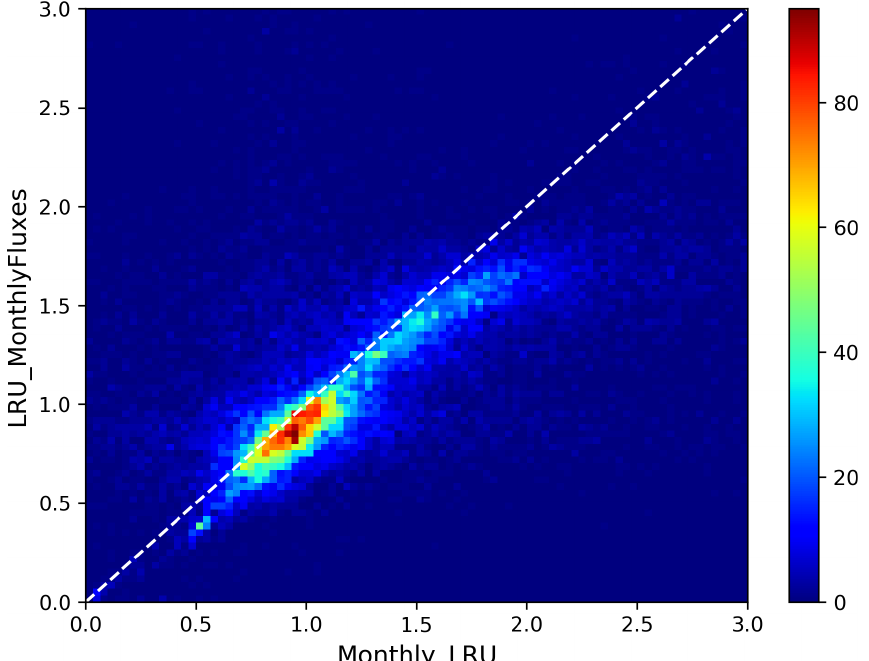
Figure C2. Bi-dimensional histogram of LRU values computed from a climatology of monthly mean fluxes (LRU_MonthlyFluxes) against a climatology of monthly means of LRU computed from original half-hourly values (Monthly_LRU). The colour bar indicates the number of occurrences per bin of 0 . 1 × 0 . 1 size. The white dashed line represents the first